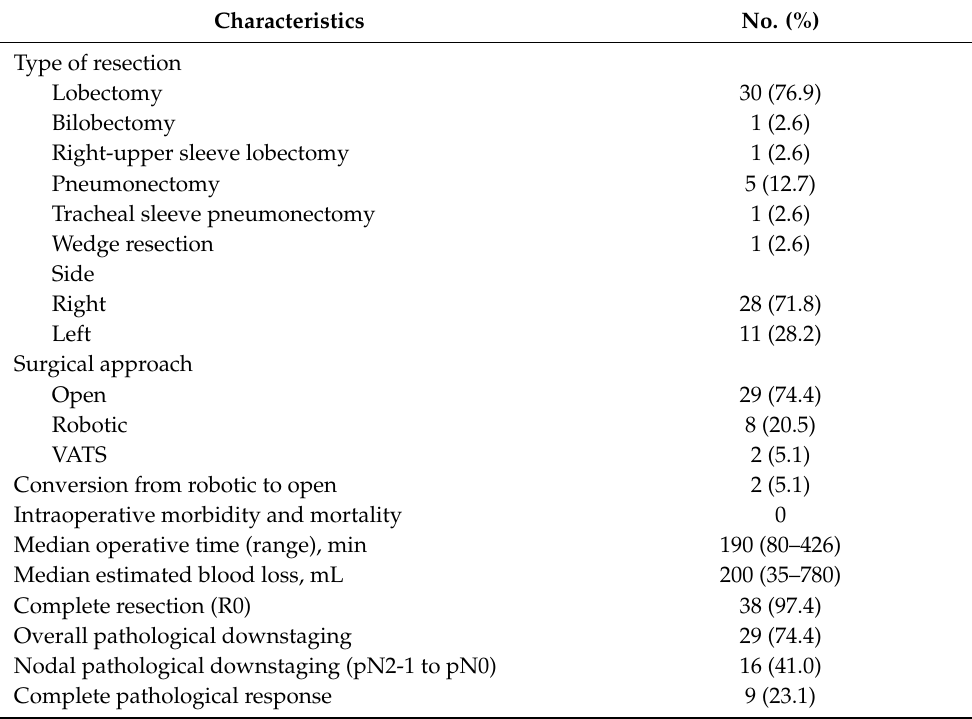
Table 2. Surgical results of the resected patients ( n =